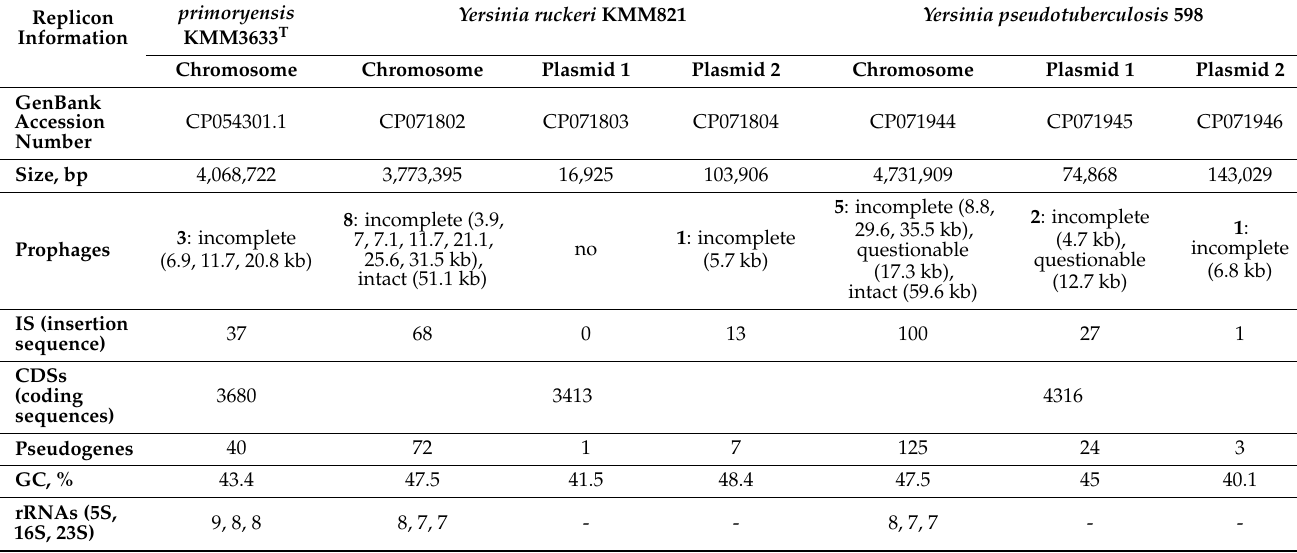
Table 1. Genome data of studied